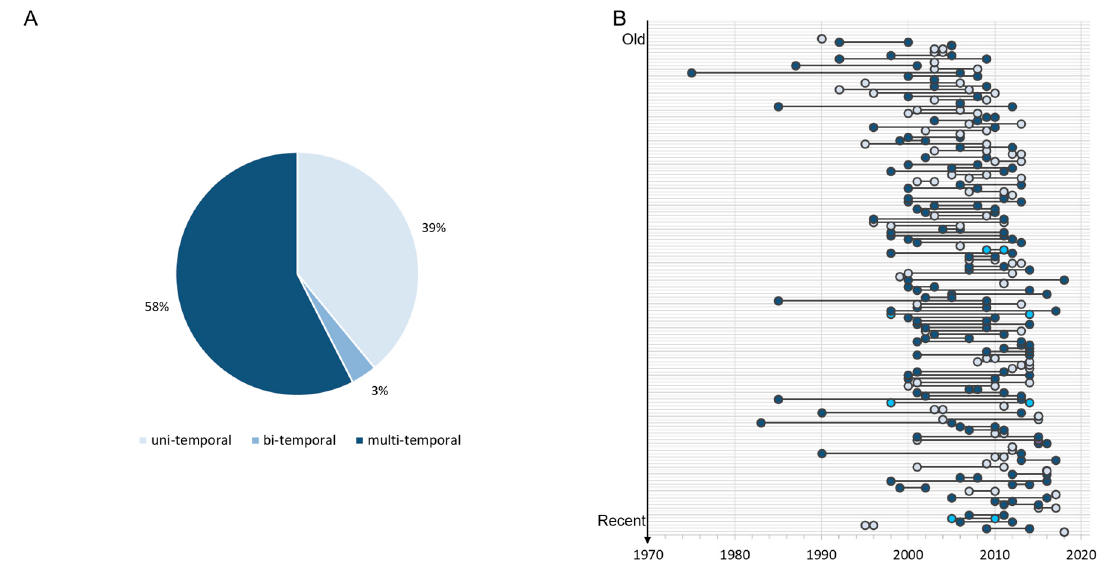
Figure 6. ( A ) Temporal resolution of articles. ( B ) Temporal extension covered by article (from oldest to newest) with color-coding as in ( A ).